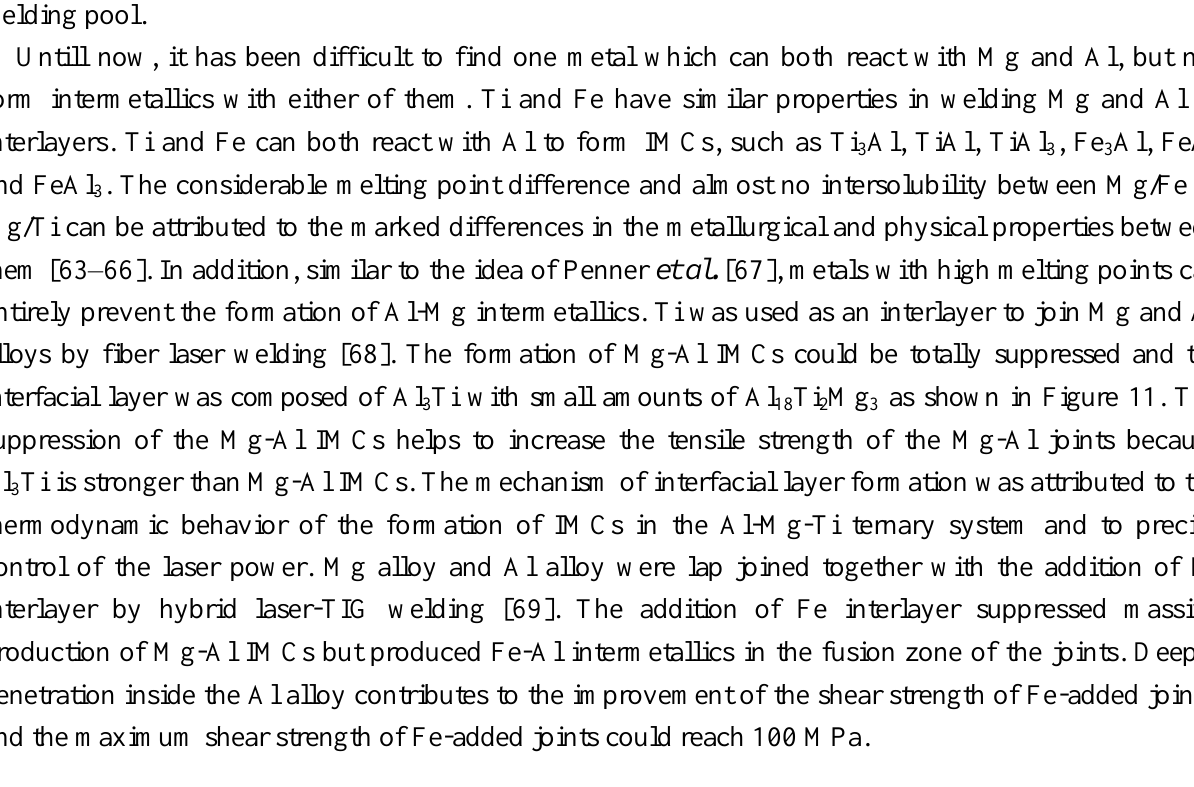
Figure 9. Microstructures of TIG welded Mg/Al joint filling with Zn filler metal [57]. ( a ) macrostructure of the joint; ( b – d ) the magnification of 1, 2 and 3 in ( a